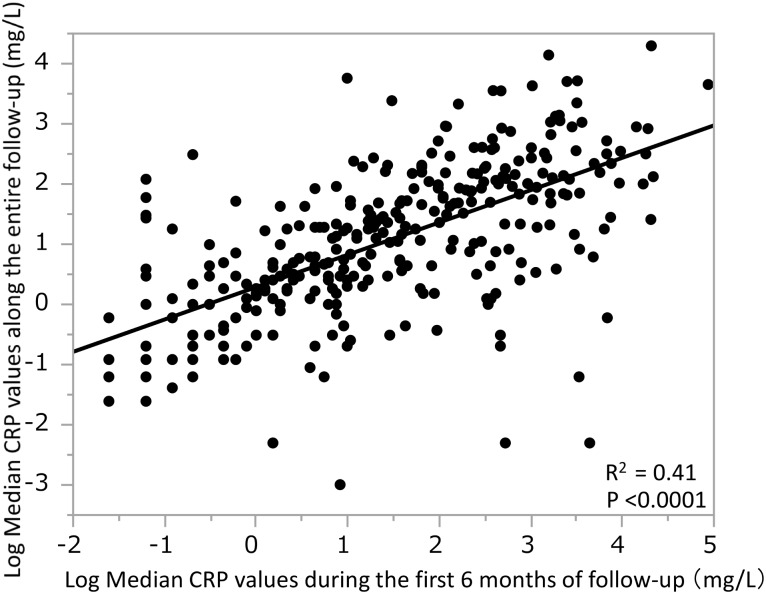
Correlation between the median CRP values along the entire follow-up (log transformed) and the median CRP values during the first 6 months of follow-up (log transformed).The median CRP values along the entire follow-up (log transformed) were positively correlated with the median CRP values during the first 6 months of follow-up (log transformed).